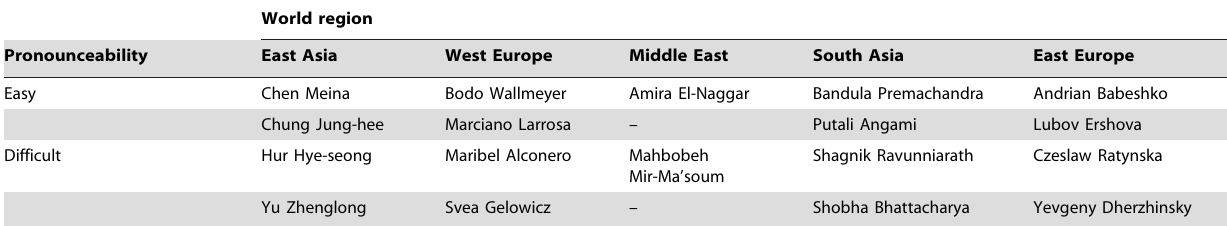
Table 1. Names, Classified by Ease of Pronunciation and World Region of